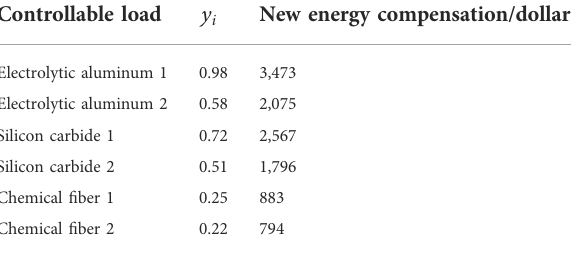
TABLE 8 Comprehensive index of the reduced loads and their new energy compensation. Controllable load y